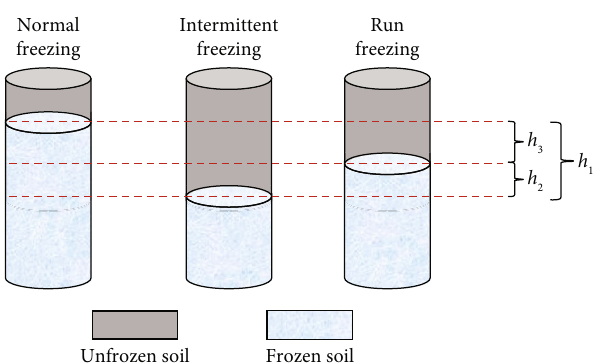
Figure 10: Schematic diagram of intermittent freezing process.